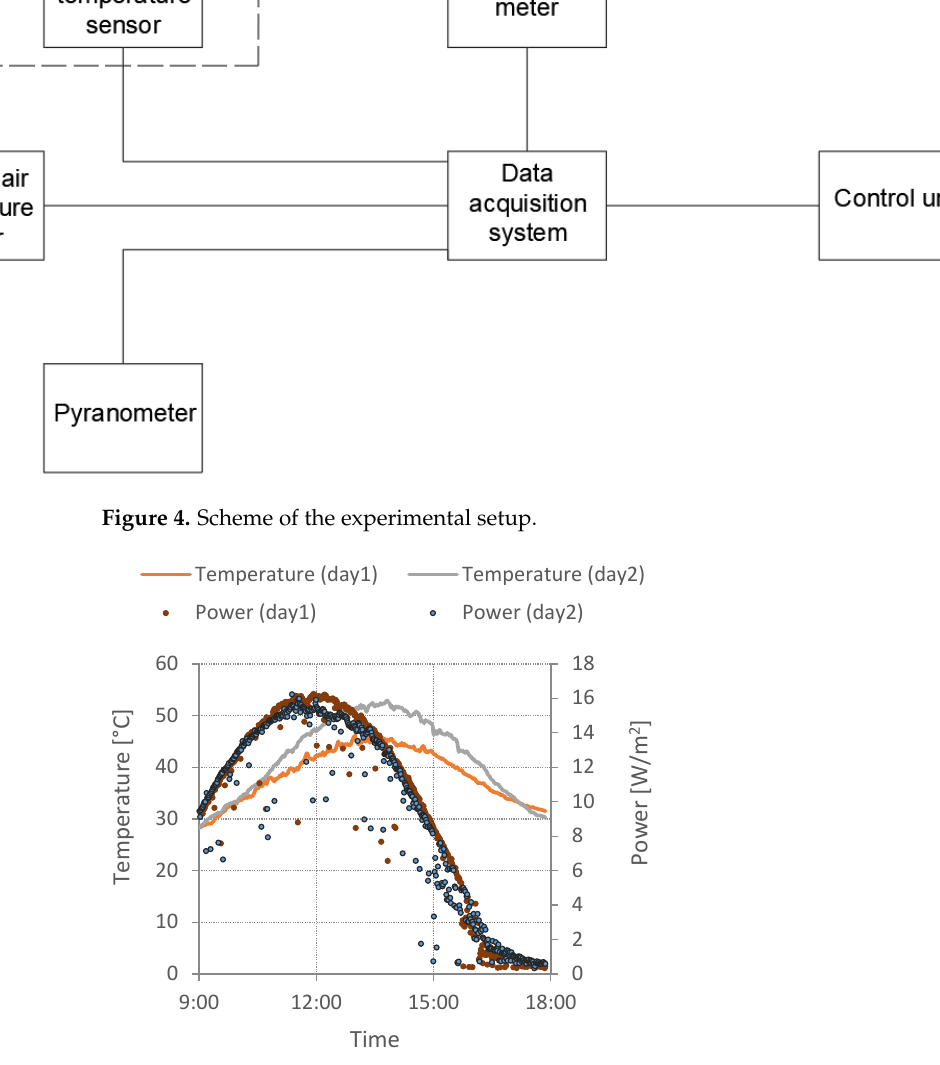
Figure 4. Scheme of the experimental setup.